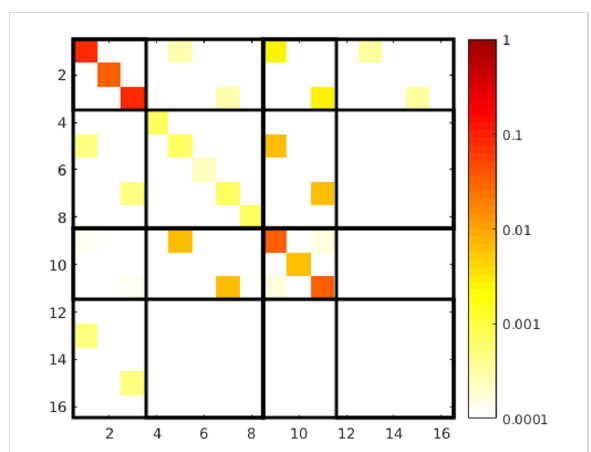
Figure 8: T-matrix entries of the sandwich particle, calculated with the presented method at 336 THz with 50 extra illuminations. See Figure 4 for a description of the